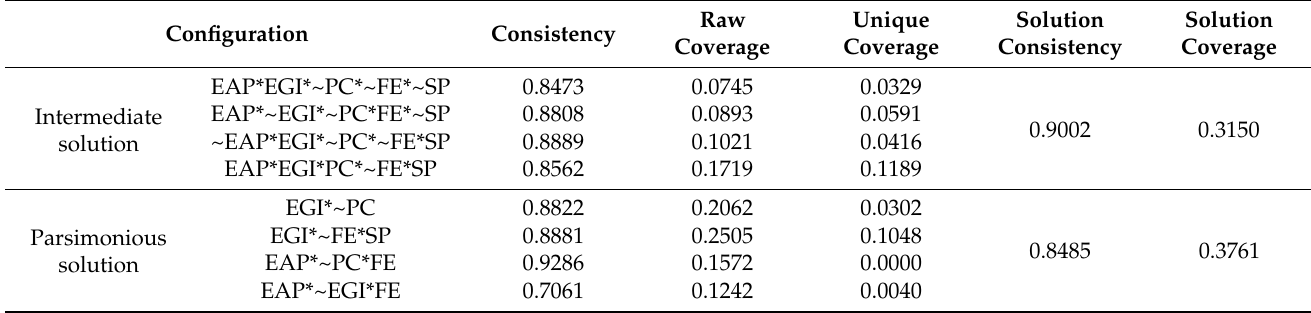
Table A1. The analysis of intermediate solutions and parsimonious solutions for high